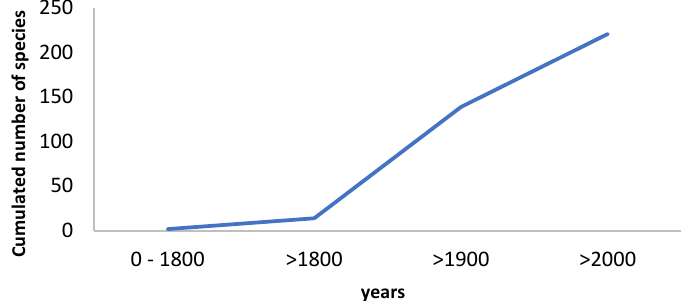
Figure 8. Cumulated number of alien species in the Baltic Sea recorded over time (with verified records from AquaNIS 2022 [7] based on the first record of alien species).